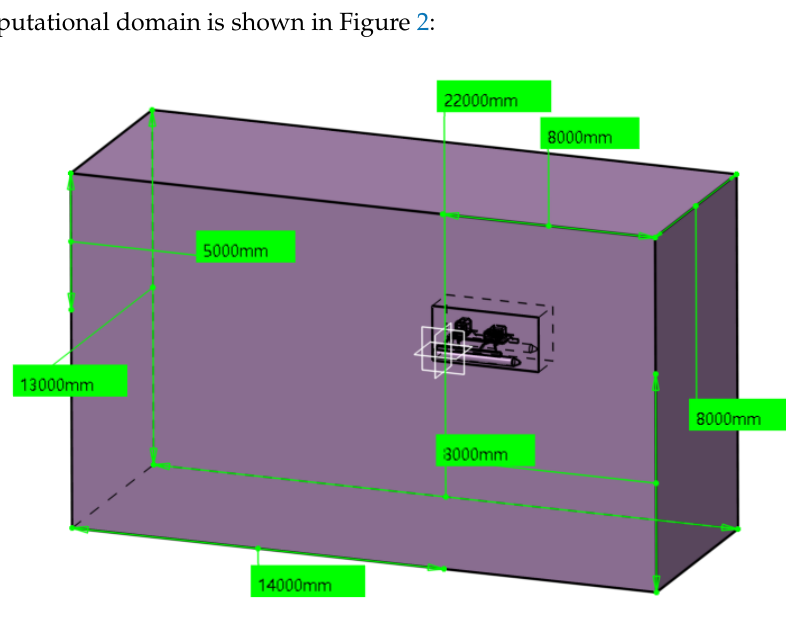
Figure 2. Computational Domain.